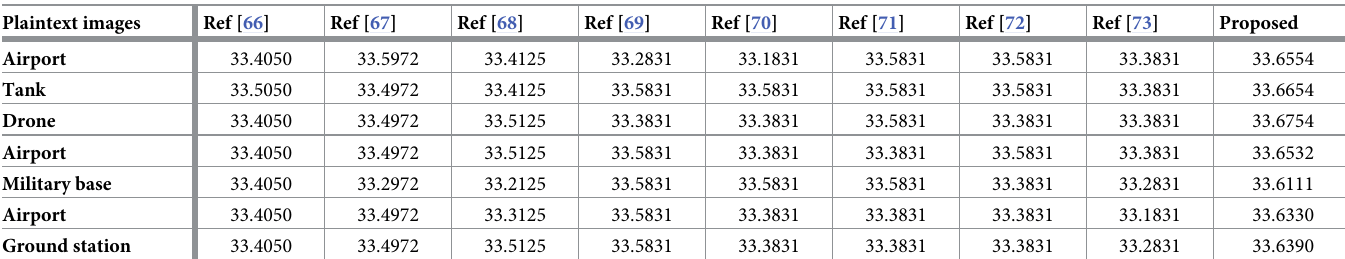
Table 14. UACI analysis.